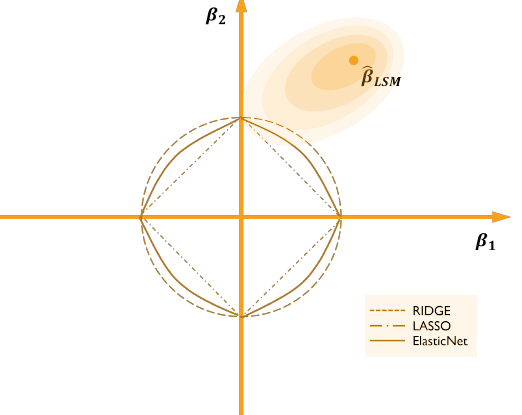
Figure 1. Parameter domains for RIDGE, LASSO and ElasticNet heuristics; ˆ β LSM is the usual least- squares